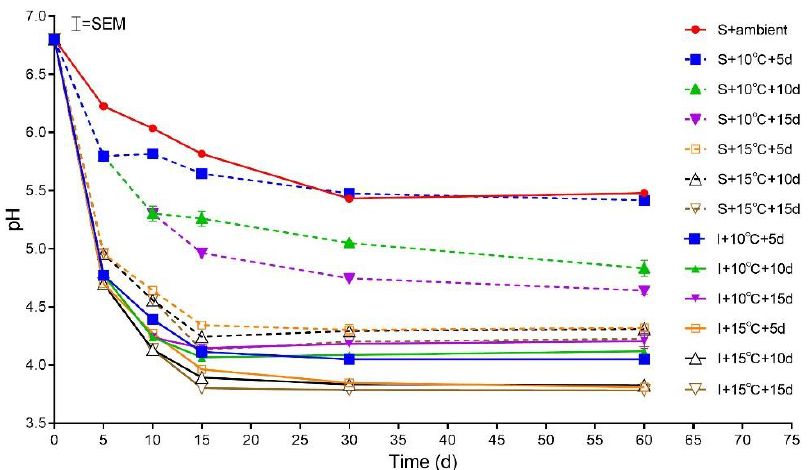
Figure 1. Dynamics of pH of silage inoculated with inherent LAB (I) and commercial LAB (S) and stored at ambient temperature and stage-increased temperatures of 10 °C and 15 °C for 5, 10 and 15 days, respectively.